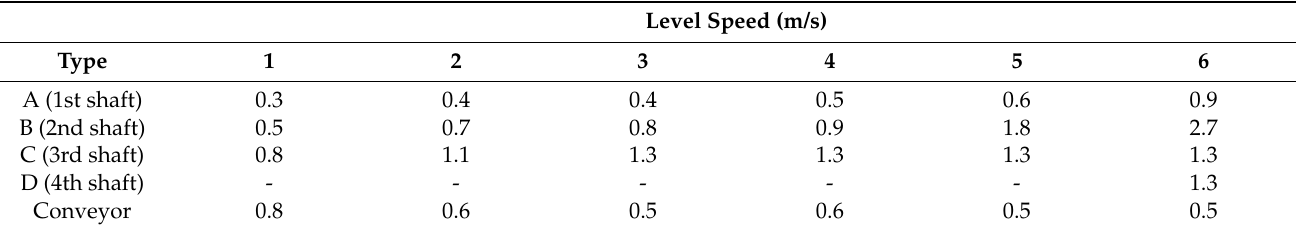
Table 3. Factor levels of drum type stem